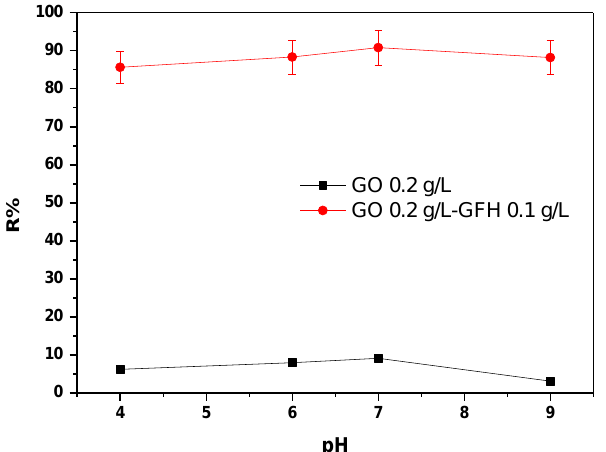
Figure 3. Effect of initial solution pH on the adsorption of As(III) onto the combination of GO (0.2 g/L) and GFH (0.1 g/L); initial As(III) concentration 100 μg/L, pH 7.0 ± 0.1, T = 298 K, contact time 24 h, in deionized water.